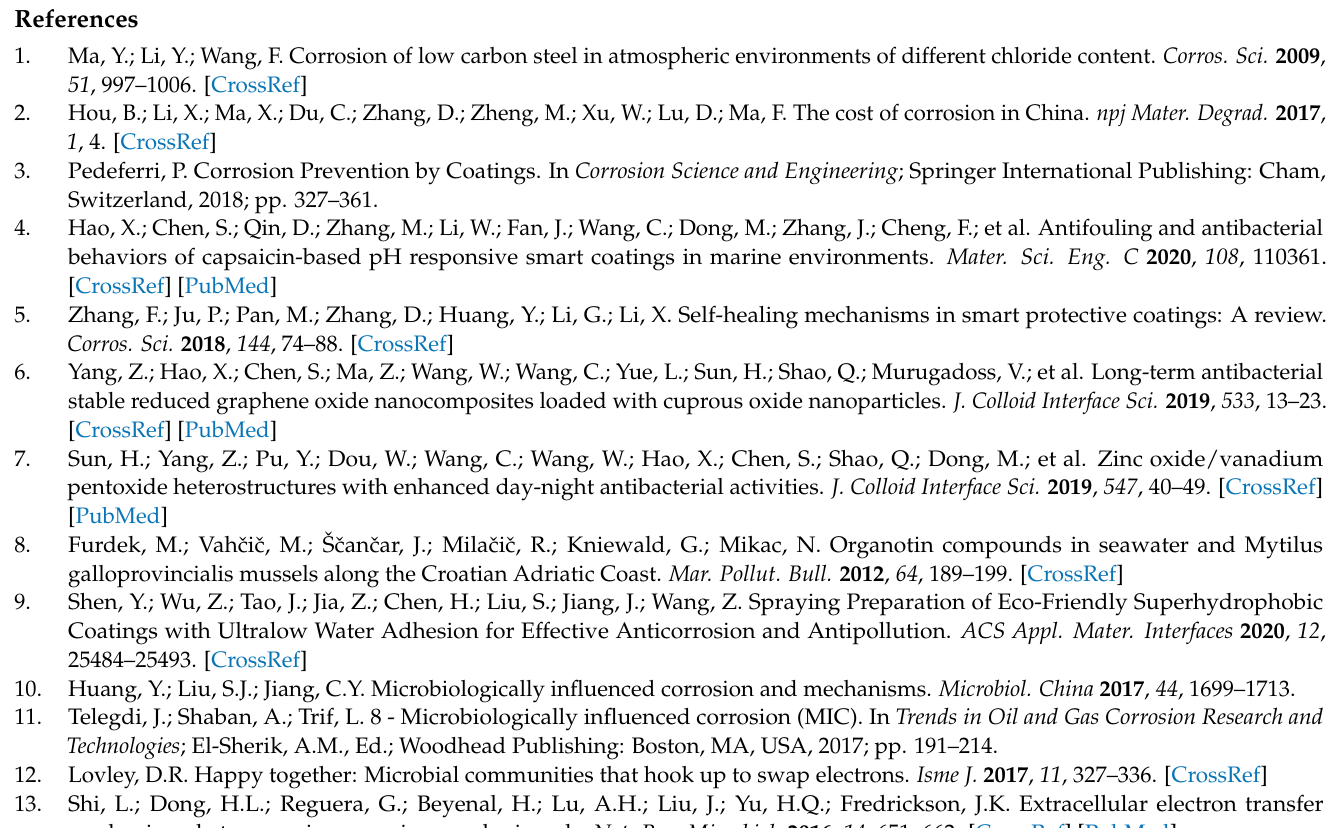
Table S1: EIS parameters of Q235 coupons in different